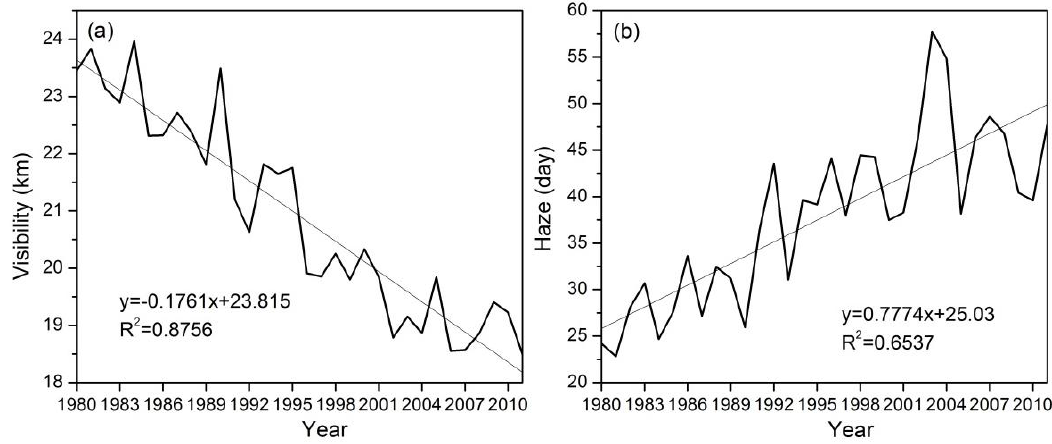
Figure 9. Change in ( a ) average visibility and ( b ) average haze days in ZJP during 1980–2011.